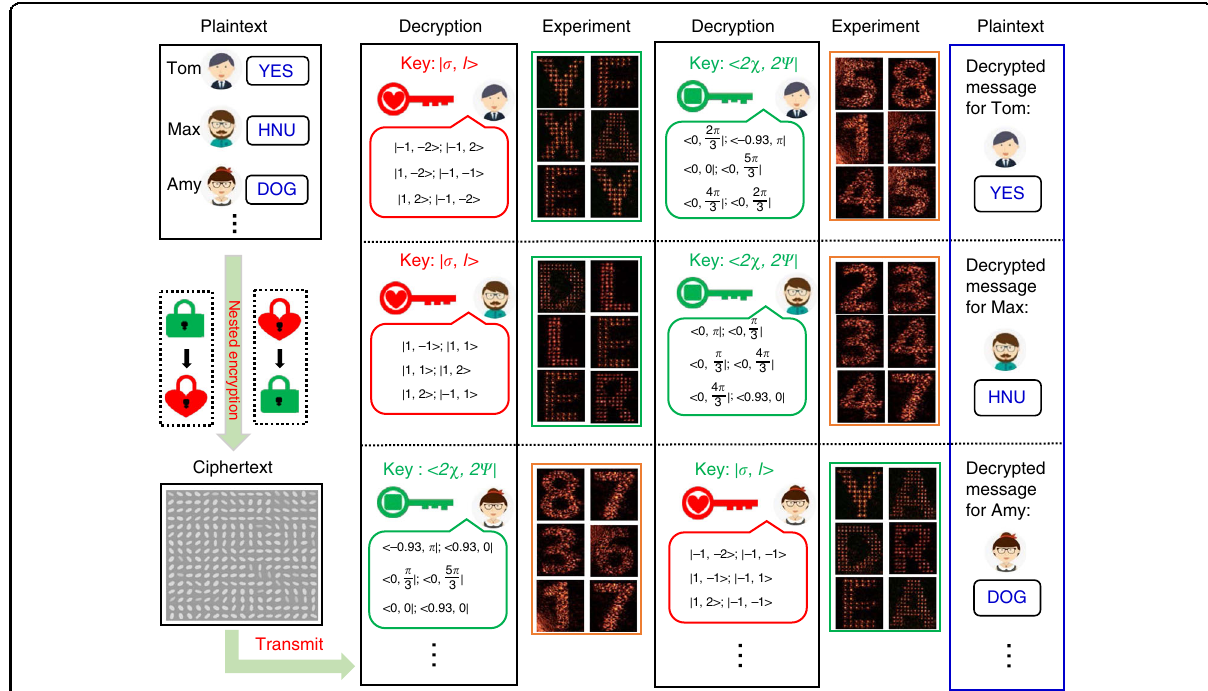
Fig. 5 Experimental demonstration of using the designed 16-bit AM meta-hologram for optical nested encryption. The messages for Tom, Max, Amy, and so forth are all nested encrypted on one metasurface that termed as ciphertext. Identical samples are sent to multiple receivers, who can decrypt their respective messages according to the customized